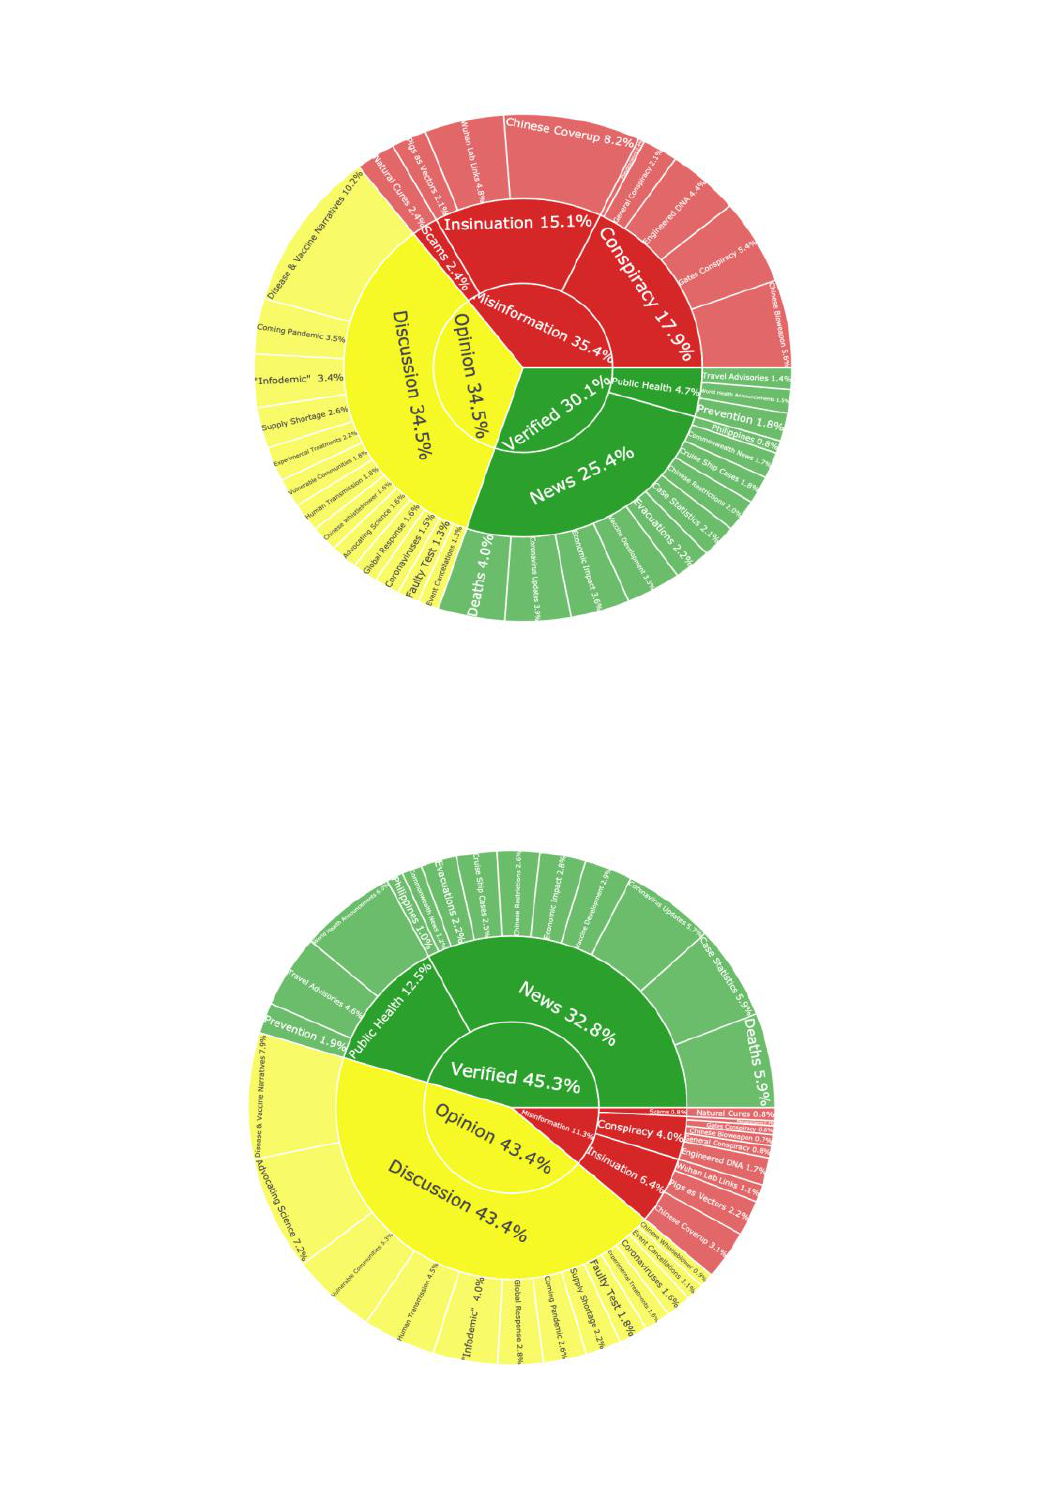
Figure 3. Breakdown of topics for both vaccine opponents (top) and vaccine proponents (bottom). Colors: red = unreliable, yellow = less reliable, green = more reliable. For an interactive version of the top figure, please see: https://broniatowski.github.io/Not-Just-Conspiracy-Theories/Figure%203a.html. For an interactive version of the bottom figure, please see: